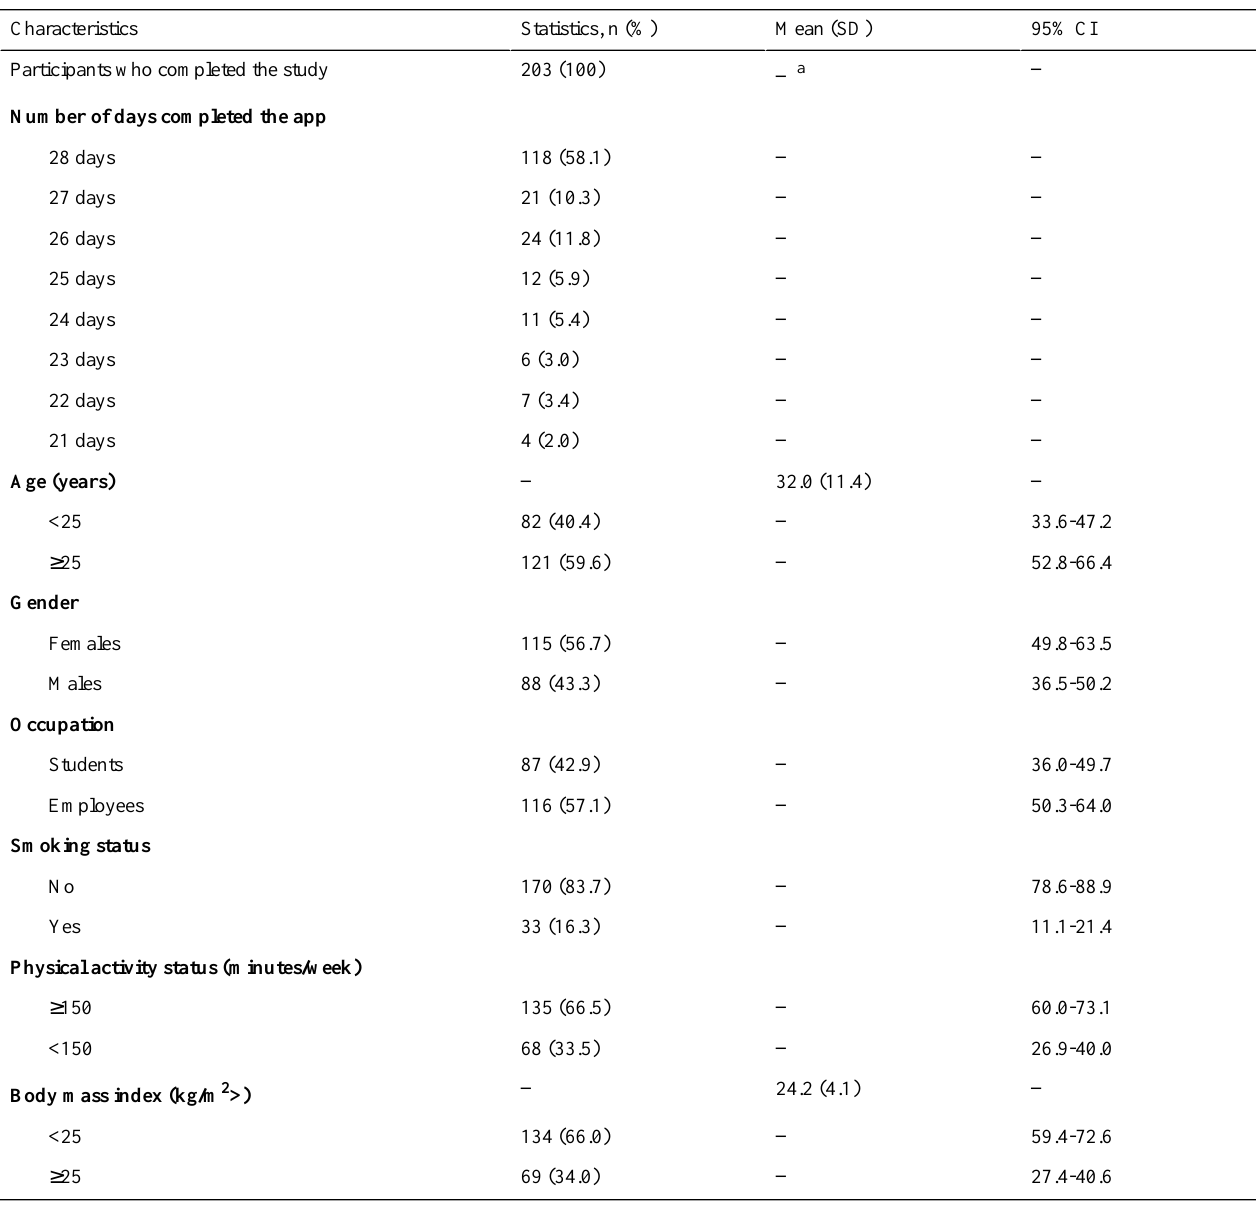
Table 1. Characteristics of study